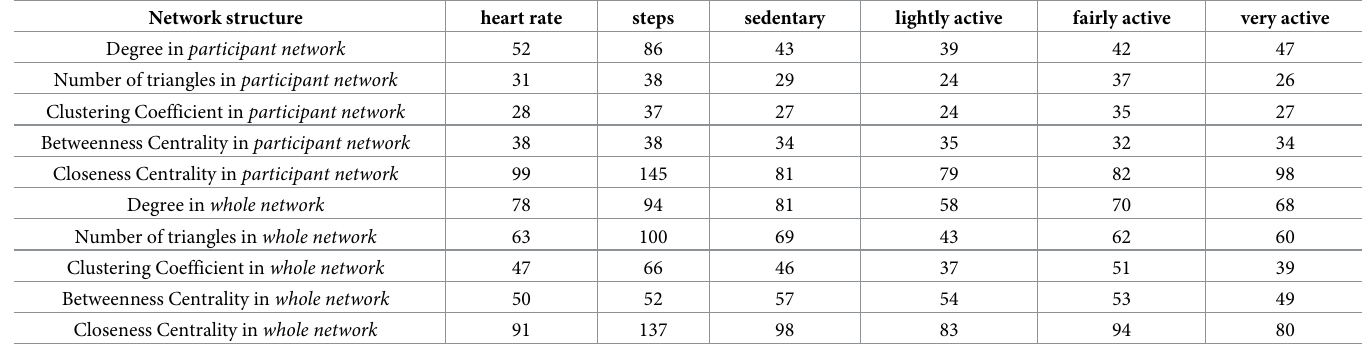
Table 4. Number of persons whose health behavior have medium to strong correlation with social network structure.